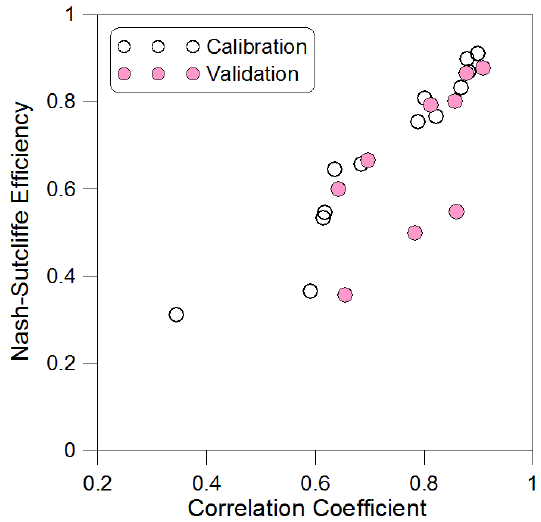
Fig. 8. Model performance vs. correlation between I CP and stream- flow. Note correlation coefficient is calculated only when ex- ceedance probability is less than 0.2. For validation, only positive NSEs are